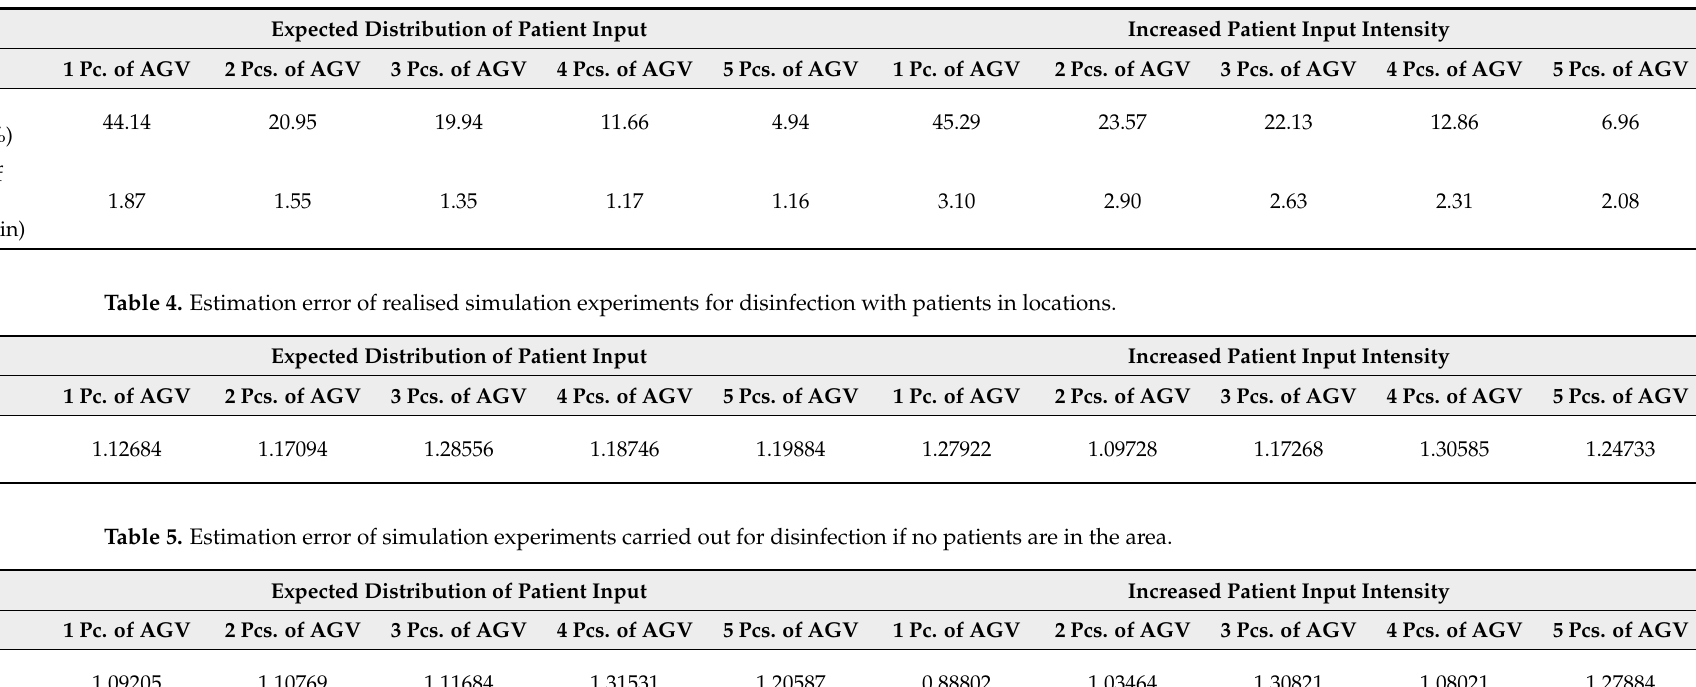
Table 3. Results of simulation experiments carried out for disinfection if no patients are in the area.